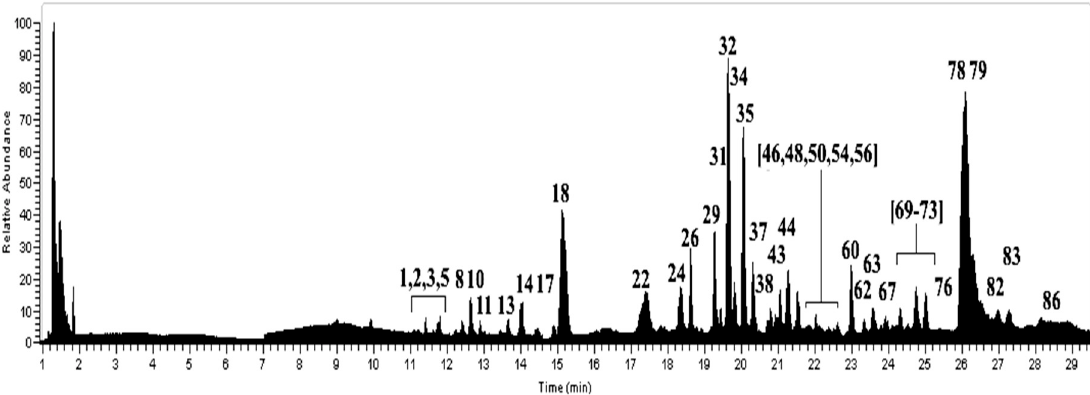
Figure 1. UHPLC-MS Chromatogram of U. barbata .